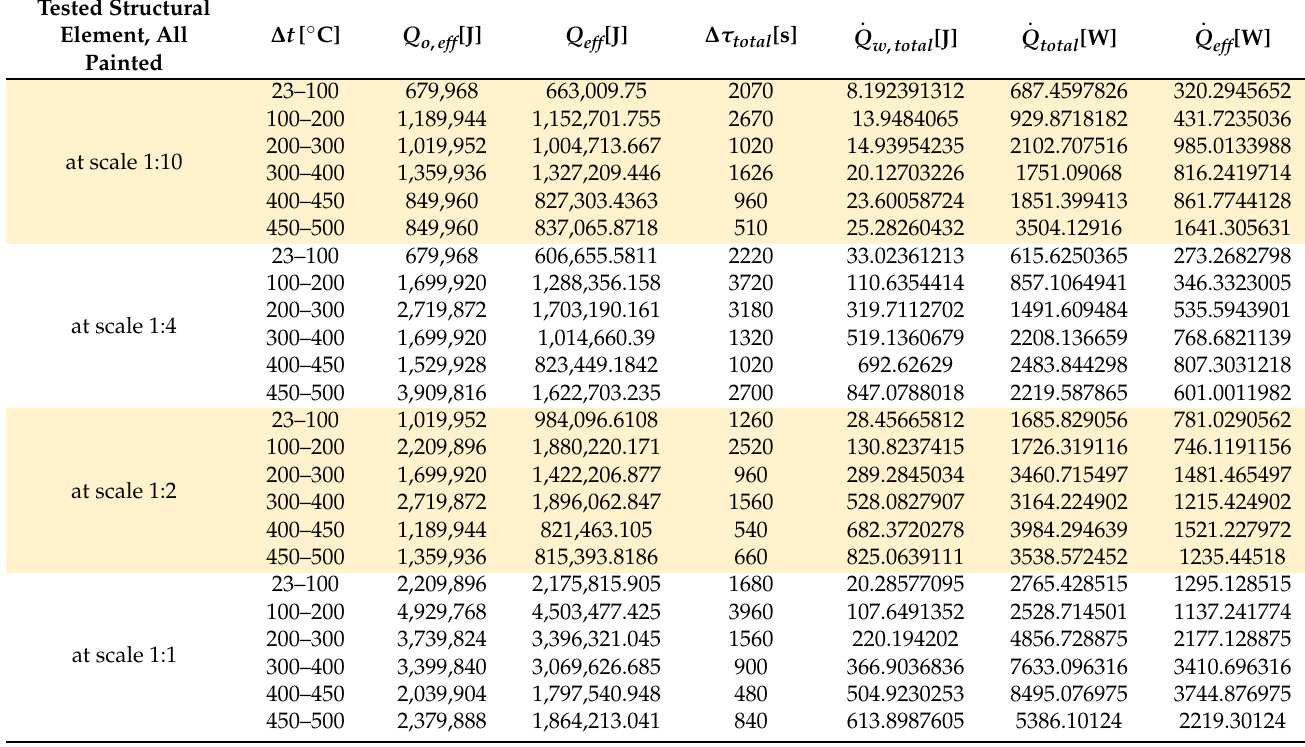
Table 3. Preliminary